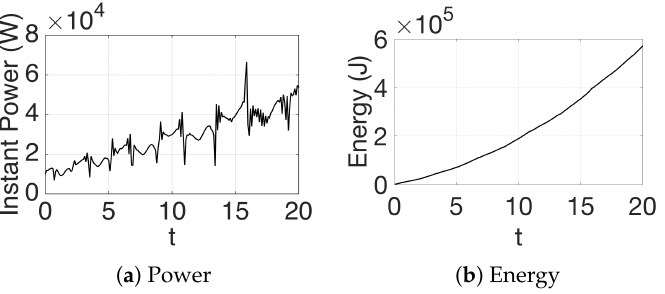
Figure 10. Power production and energy for the 3D